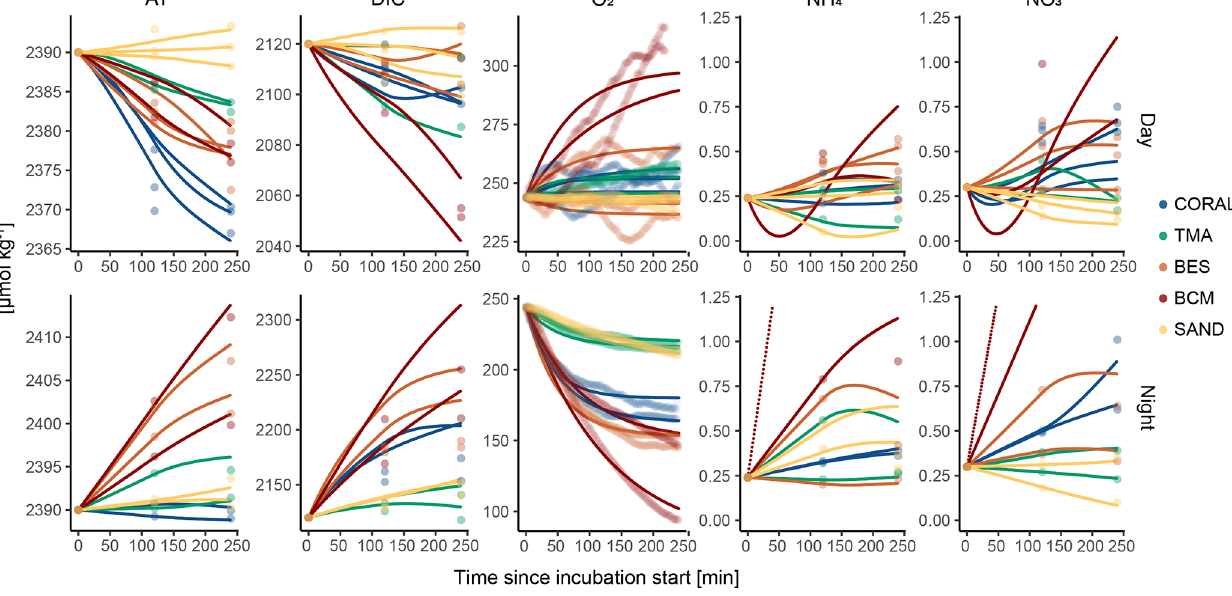
Figure 5. Illustrative results of the model (coloured lines) employed to infer the process rates from measured data. The top graphs depict the model output of incubations performed during the day, while the bottom ones show the output for night-time incubations. Points repre- sent measured values of the state variables inside and outside the tent. The measured data were centred for graphic visualisation purposes (non-centred data for all incubations can be found in Table S2). The blue, green, orange, red, and yellow colours represent communities dominated by coral, turf and macroalgae, bioeroding sponges, benthic cyanobacterial mats, and sand, respectively. Note that NH 4 and NO 3 measurements in BCM incubations at night-time were much higher than the rest. The y axes of the graphs depicting NH 4 and NO 3 results were therefore truncated in order to better visualise model output of all other incubations (model output for the off-chart BCM incubation can be found in Fig.